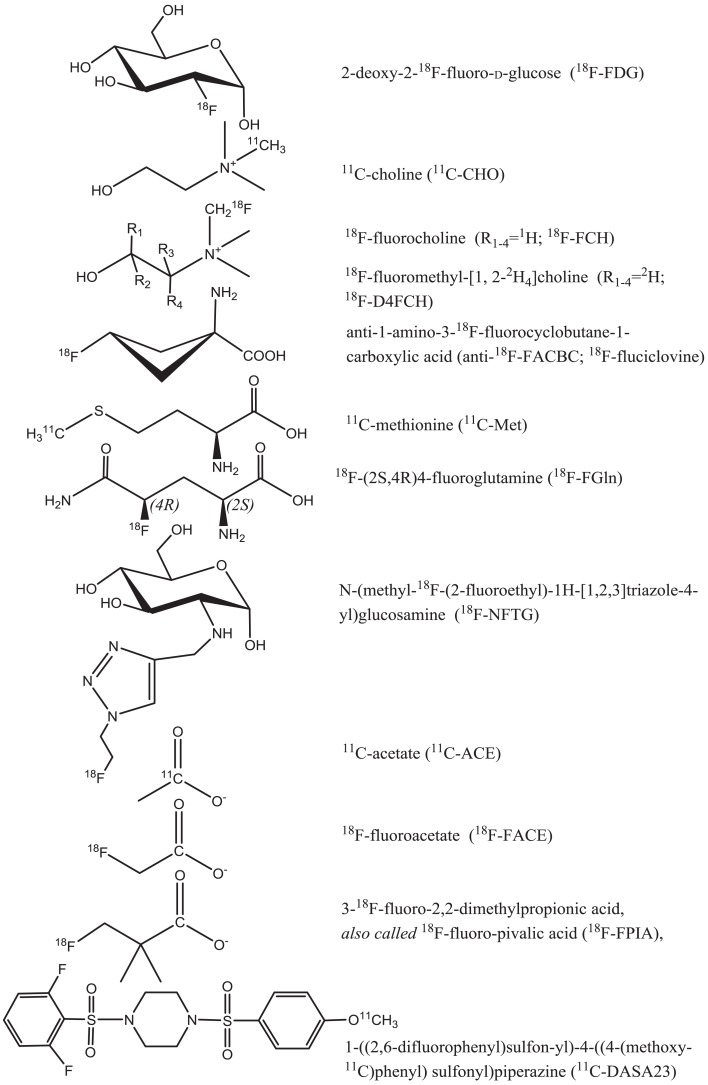
Radioprobes utilized in the imaging of tumor cell metabolism.